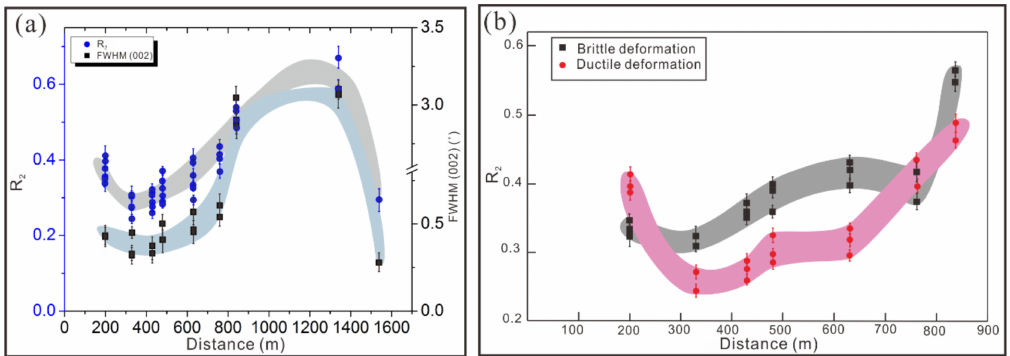
Figure 7. ( a ) FWHM (002) and R 2 values of CBG versus distance from the intrusion. ( b ) R 2 values of di ff erent deformed CBG versus distance from the intrusion (see Supplementary Table S1 for Raman parameters of all